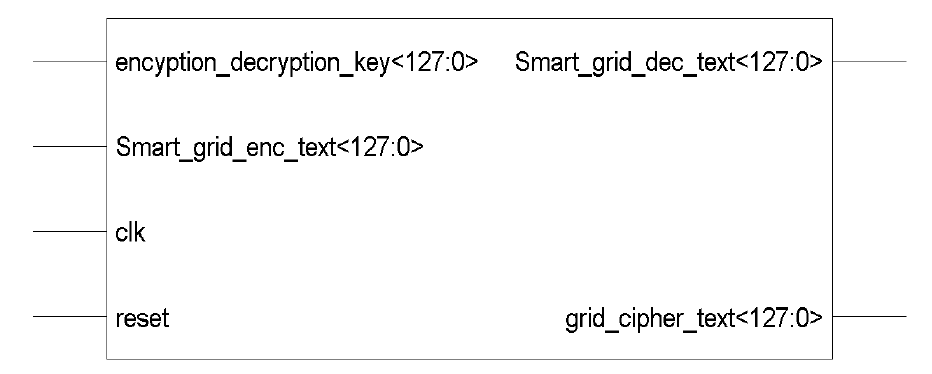
Figure 4 RTL view of grid encryption logic Table 2 Pin Details for smart grid TACIT decryption